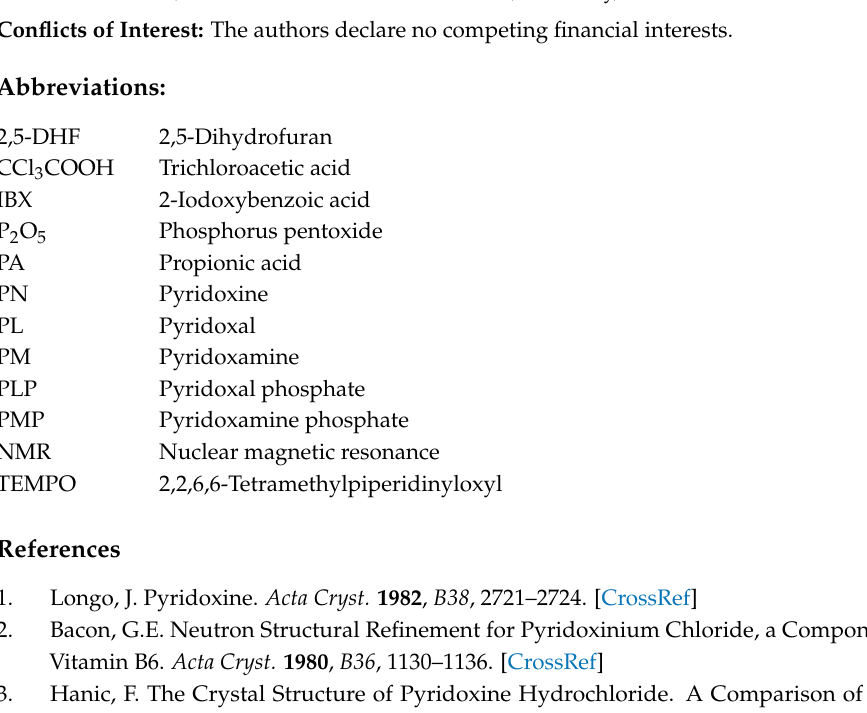
Figure S13. 1 H spectrum of 2-( 13 C 1 )methyl-3-hydroxy-4,5-epoxydimethyl(2,3- 13 C 2 )pyridine. Figure S14. 13 C spectrum of 2-( 13 C 1 )methyl-3-hydroxy-4,5-epoxydimethyl(2,3- 13 C 2 )pyridine. Figure S15. 1 H spectrum of ( 13 C 3 )pyridoxine. Figure S16. 13 C spectrum of ( 13 C 3 )pyridoxine. Figure S17. 1 H spectrum of ( 13 C 3 )N-(pyridoxylidene)methylamine. Figure S18. 13 C spectrum of ( 13 C 3 )N-(pyridoxylidene)methylamine. Figure S19. 1 H spectrum of ( 13 C 3 )pyridoxal. Figure S20. 13 C spectrum of ( 13 C 3 )pyridoxal. Figure S21. 1 H spectrum of ( 13 C 3 )N-(pyridoxylidene)hydroxylamine. Figure S22. 13 C spectrum of ( 13 C 3 )N-(pyridoxylidene)hydroxylamine. Figure S23. 1 H spectrum of ( 13 C 3 )pyridoxamine. Figure S24. 13 C spectrum of ( 13 C 3